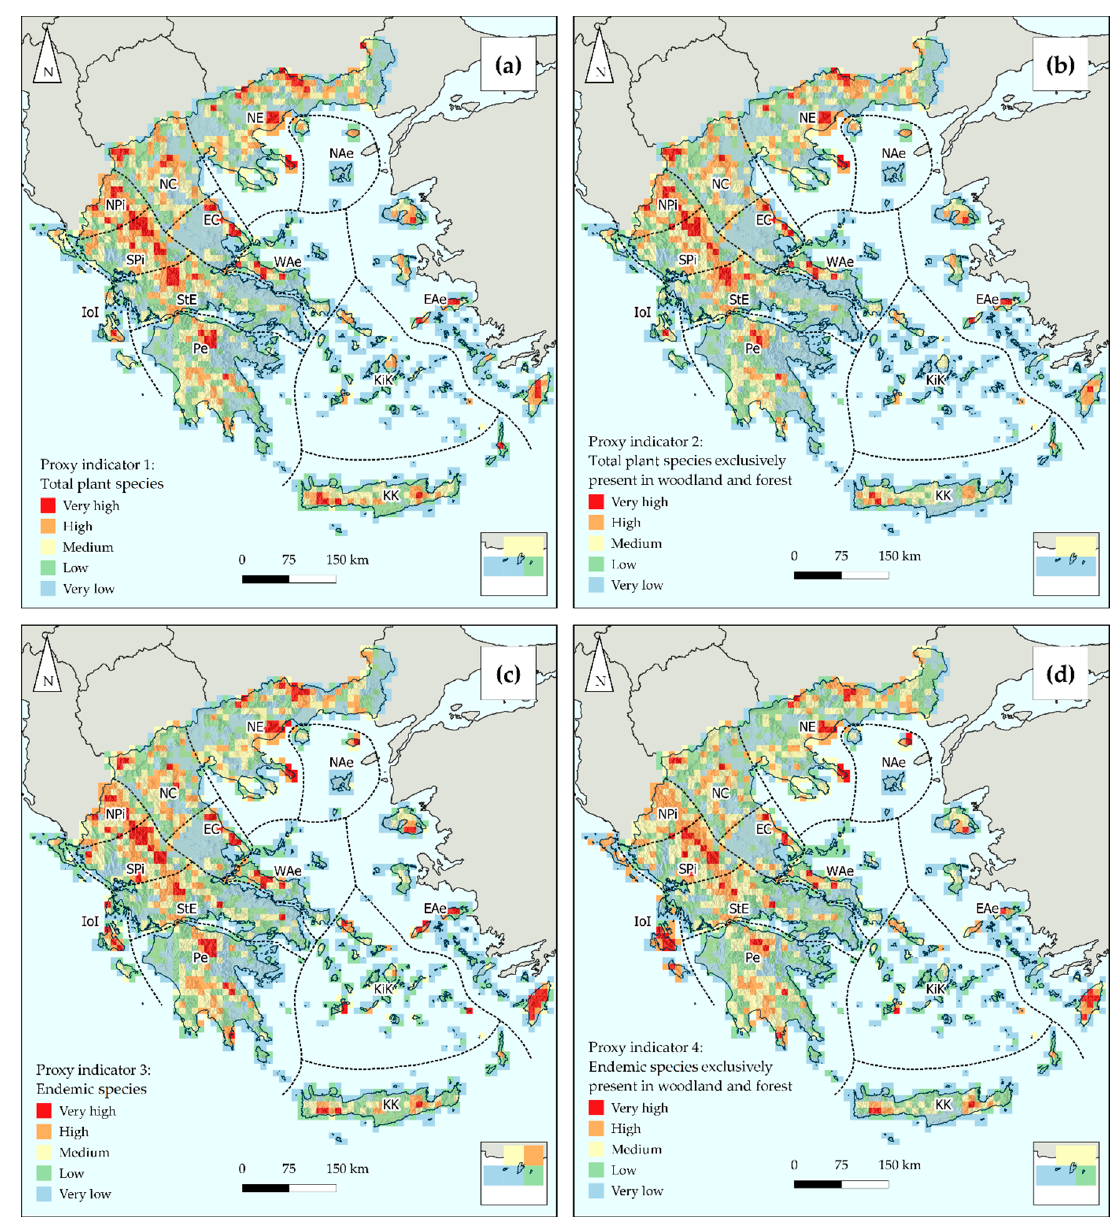
Figure 6. Thematic representation of the four ecosystem asset proxy indicators: ( a ) Total plant species index; ( b ) total plant species exclusively present in woodland and forest index; ( c ) endemic species index; ( d ) endemic species exclusively present in woodland and forest index. Floristic regions of Greece [31,34] are also depicted: East Aegean islands (EAe), East Central Greece (EC), Ionian Islands (IoI), Kriti and Karpathos (KK), Kiklades (KiK), North Aegean islands (NAe), North Pindos (NPi), North Central Greece (NC), North-East Greece (NE), Peloponnisos (Pe), South Pindos (SPi), Sterea Ellas (StE), West Aegean islands, (WAe).